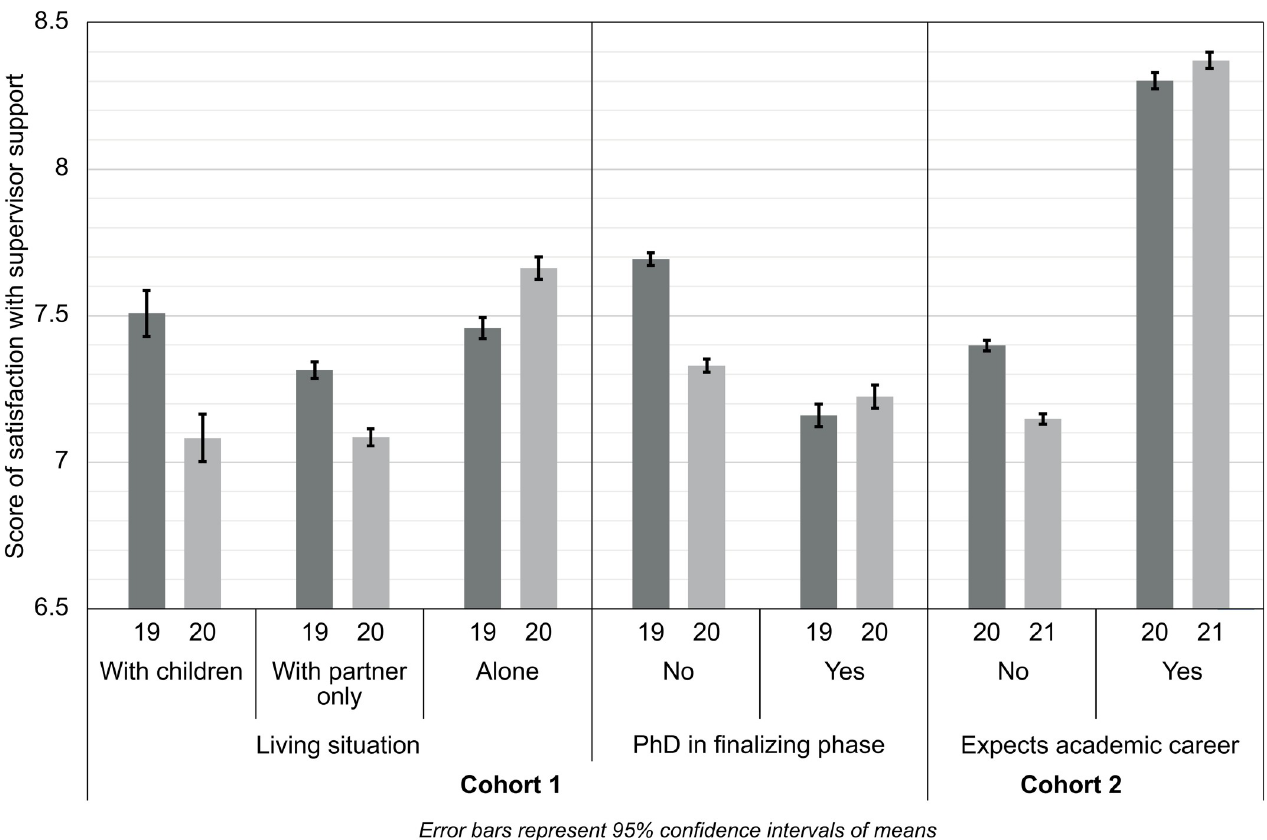
Fig 1. Estimated marginal means of score of satisfaction with supervisor support over